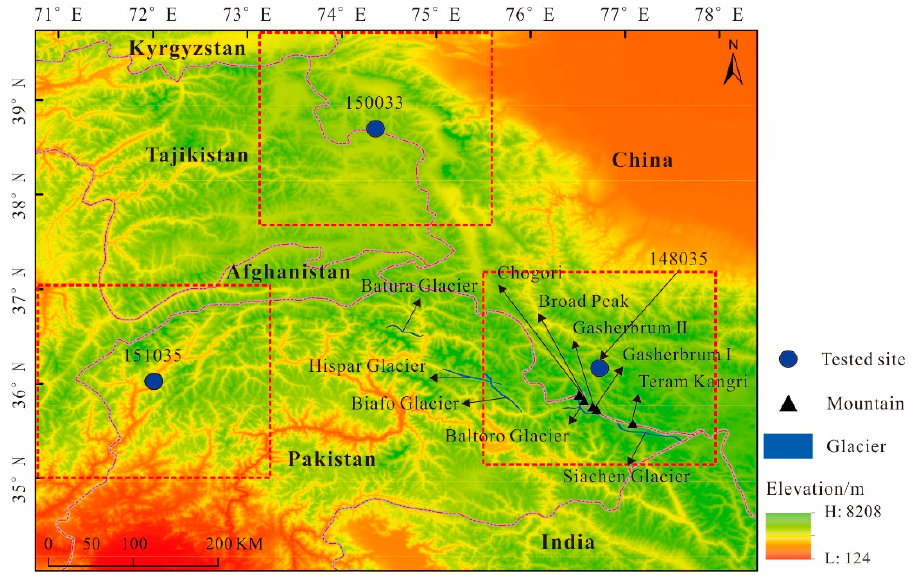
Figure 1. Location of the study area.